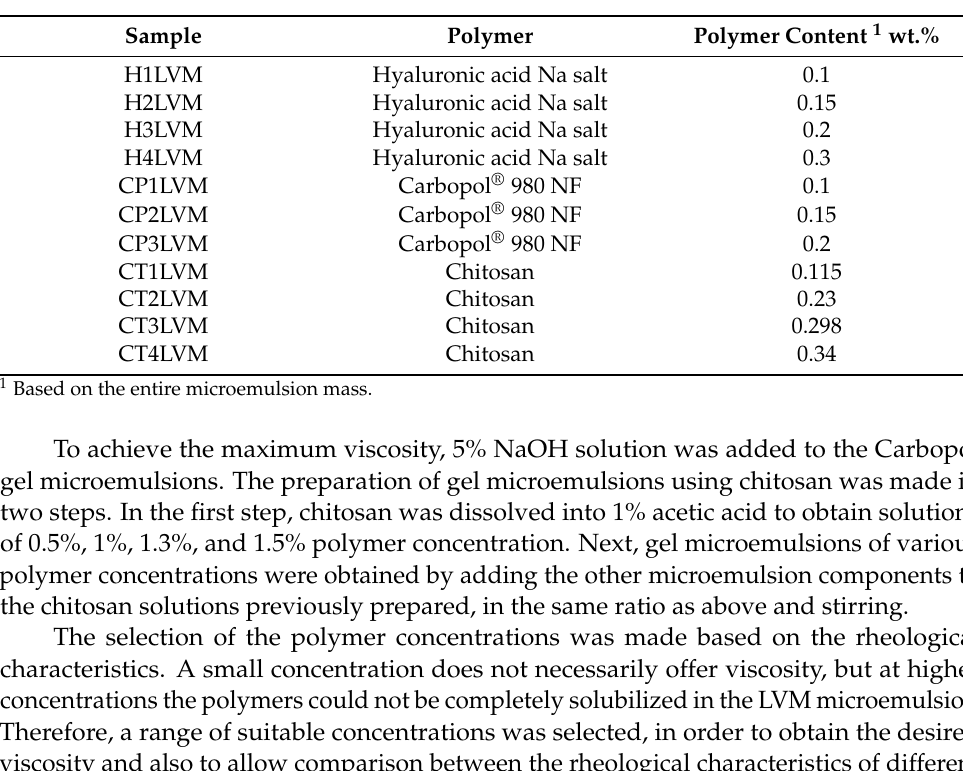
Table 1. Polymer content of the gel microemulsions